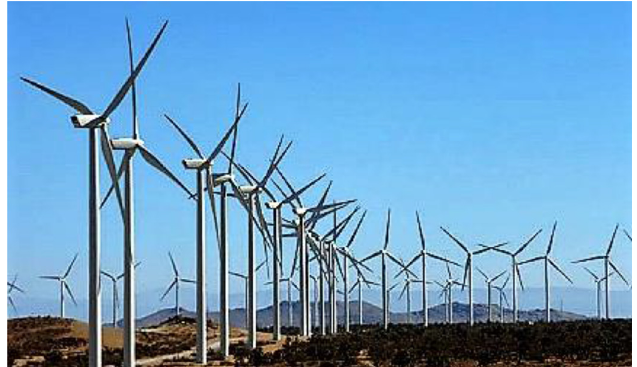
Fig. 23. US largest on-shore wind farm, 1550 MW.